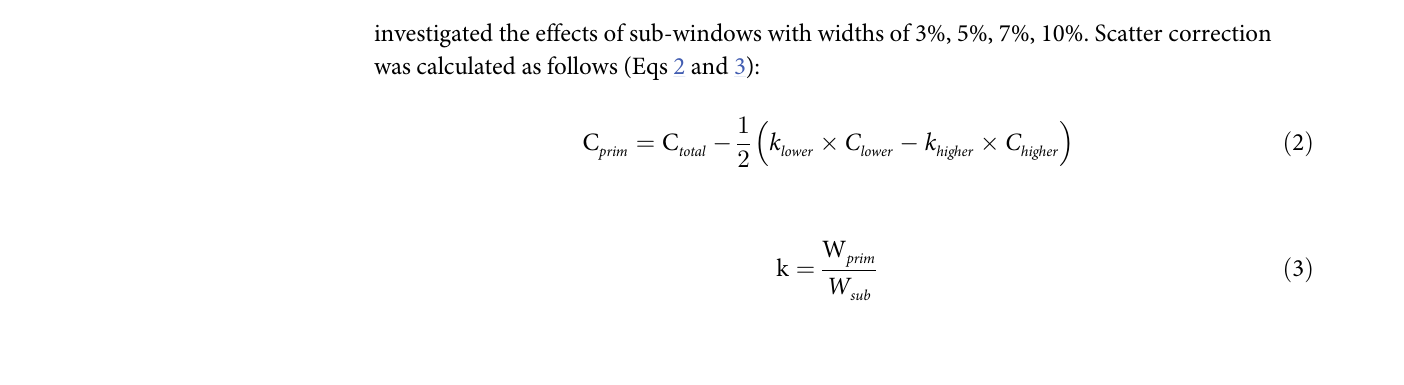
Fig 1. Setup of NEMA SPECT triple line source phantom. Overview (a), and CT axial (b) and coronal (c) views of triple line source phantom.